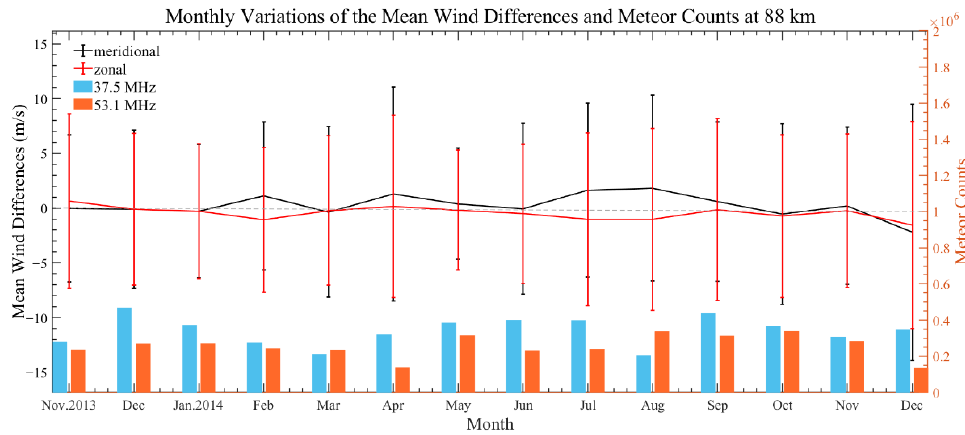
Figure 10. The monthly variations of the mean wind differences and meteor counts at 88 km. The red and black lines are the monthly mean wind differences with standard deviation error bars corresponding to the zonal and meridional wind components, respectively. The blue and orange bars represent the monthly meteor counts of the 37.5 MHz MR and the 53.1 MHz MR. The gray dashed line represents the mean wind difference of 0.